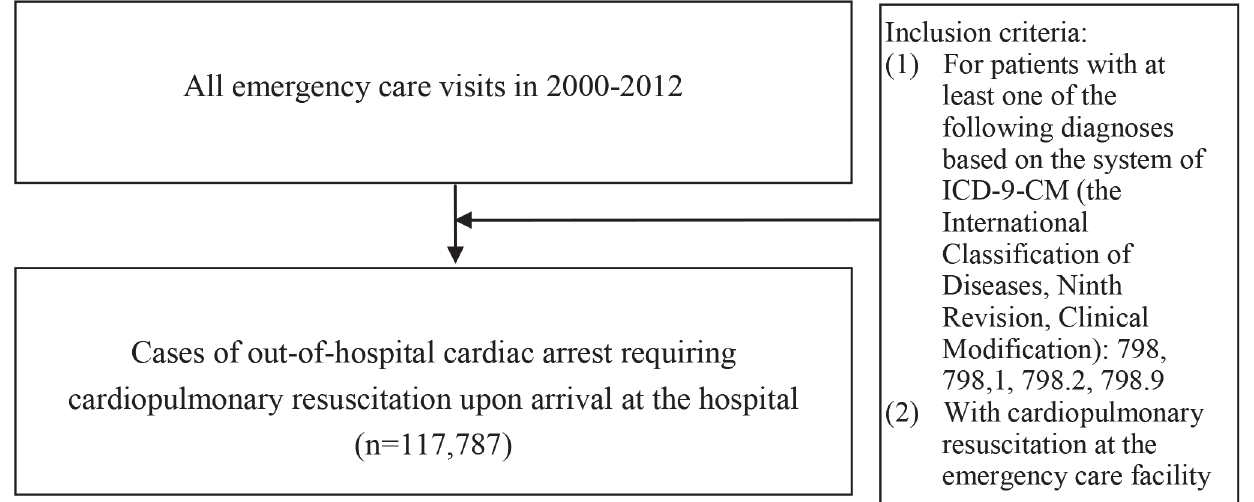
Fig 1. The selection process of study subjects with out-of-hospital cardiac arrest requiring cardiopulmonary resuscitation upon arrival.